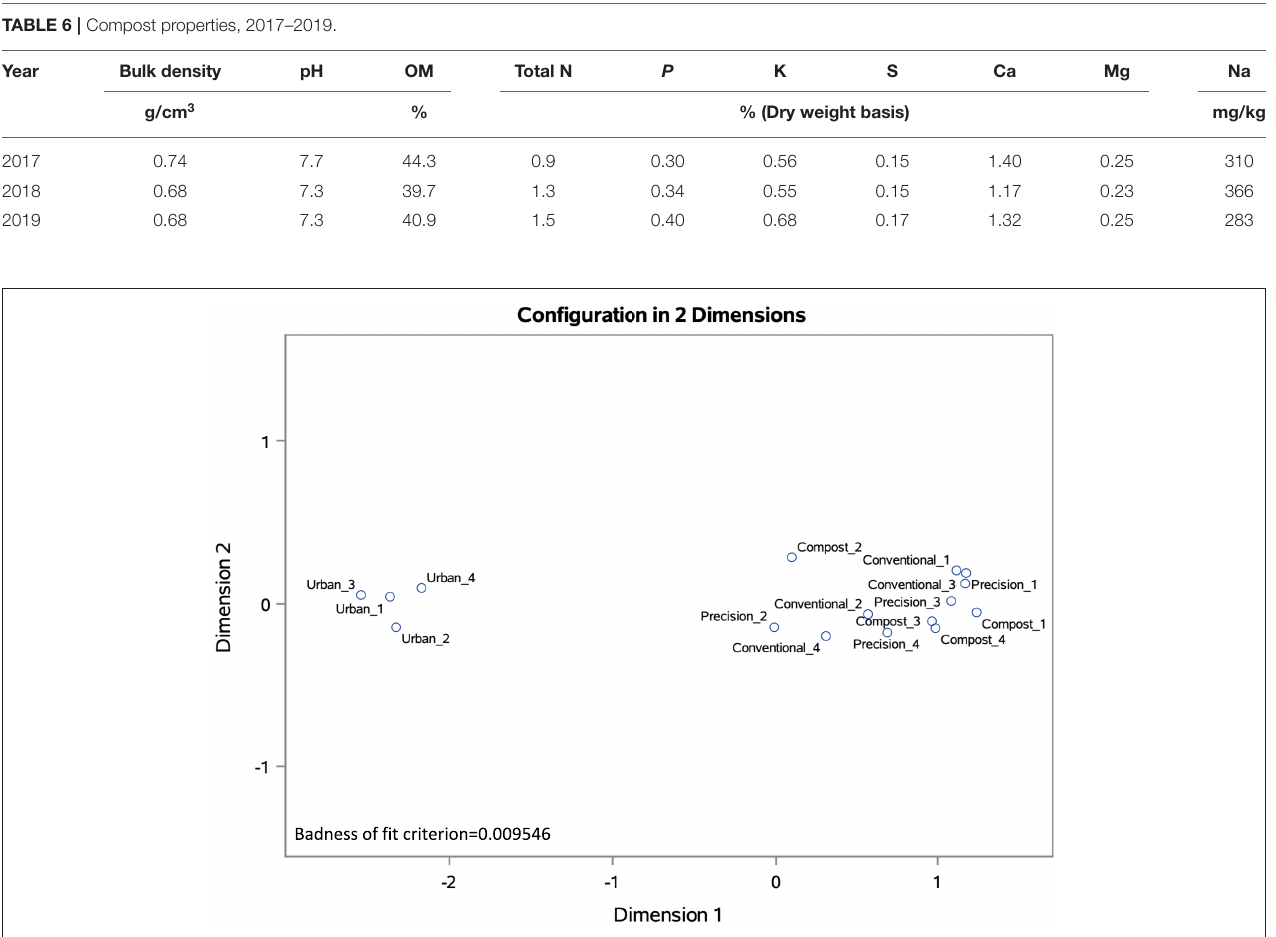
FIGURE 3 | NMDS ordination based on Bray-Curtis dissimilarity matrix for 2017 soil chemical characteristics (CEC, pH, OM, P, K, S, Ca, Mg, Na, Fe, Mn, Cu, Zn, and Al) of 16 experimental plots, four replicates per treatment.